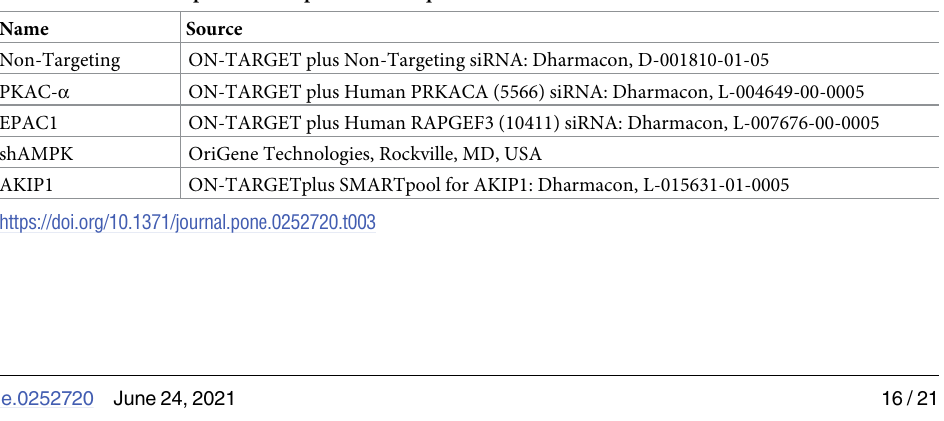
Table 3. ON-TARGET plus SMART pool siRNA